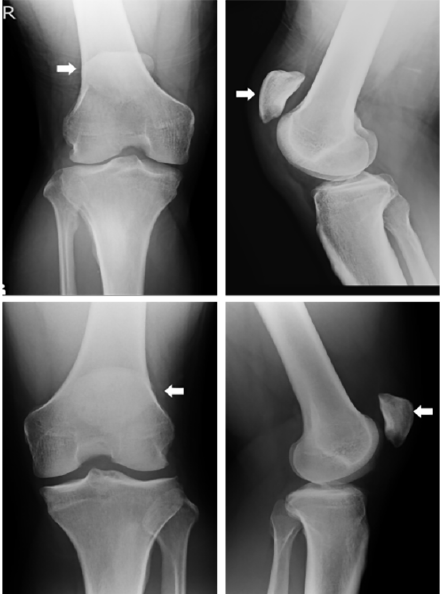
Image 1. High-riding patella (patella alta) (arrows): (upper) right knee and (lower) left knee. The Insall-Salvati ratio (length from the tibial tubercle to the inferior patellar pole divided by the length of the patella), as seen on the lateral view radiograph, is 1.86 in the right knee and 1.60 in the left knee. (Ratio >1.2 is defined as patella alta.)